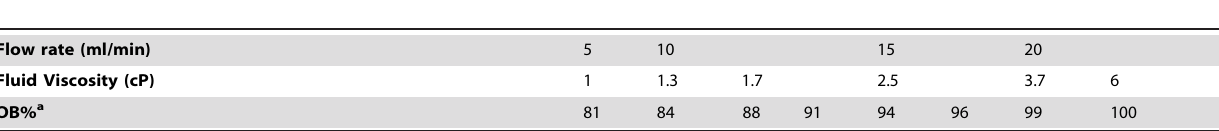
Table 1. Summary of the experimental parameters values investigated in the present study to test the effects on the renal pelvic